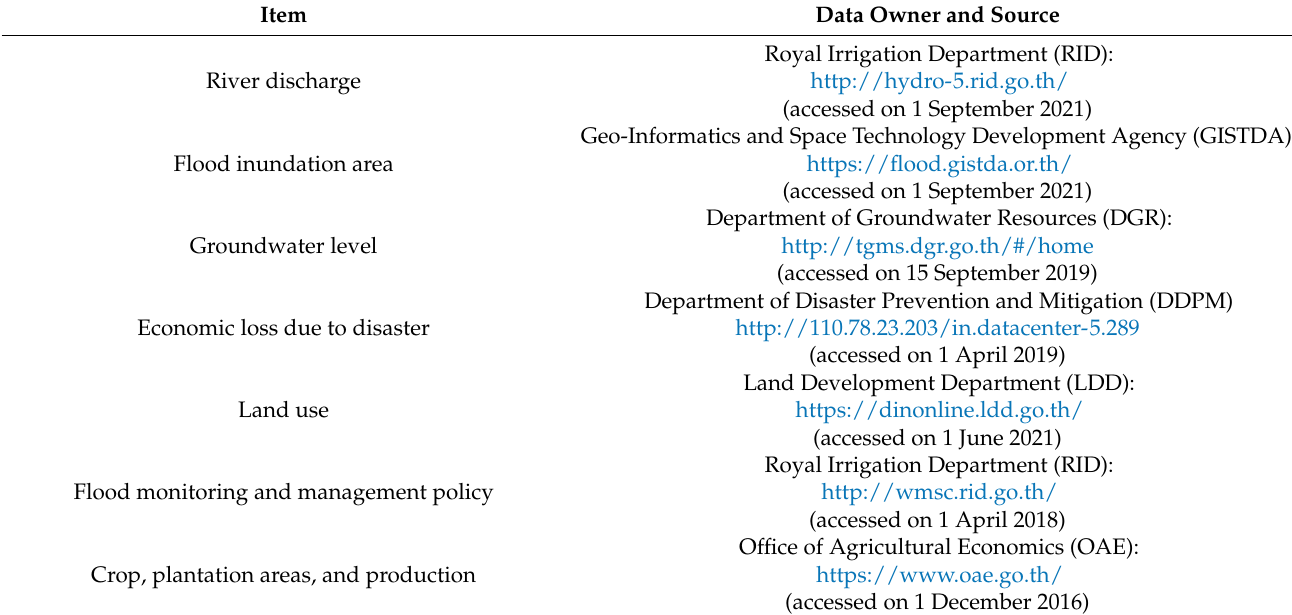
Table 1. Data used in this